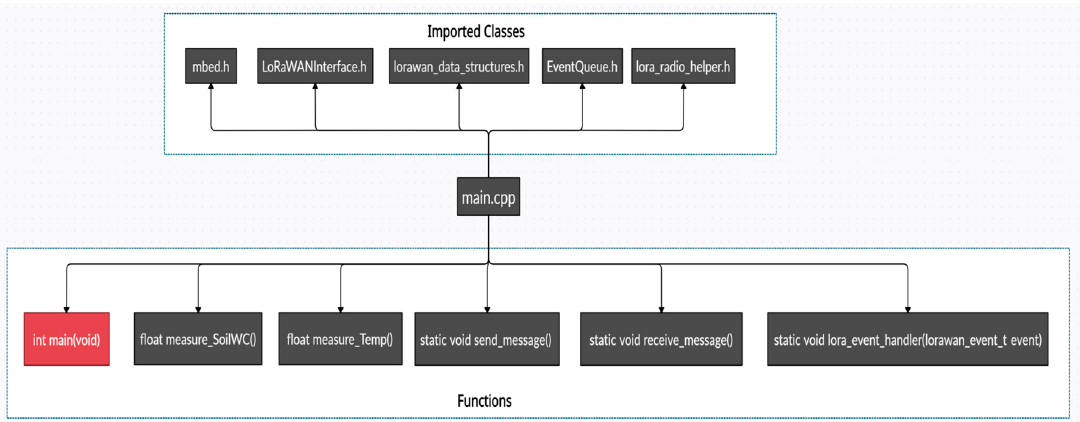
Figure 5. Embedded software implementation for the Plant Node.